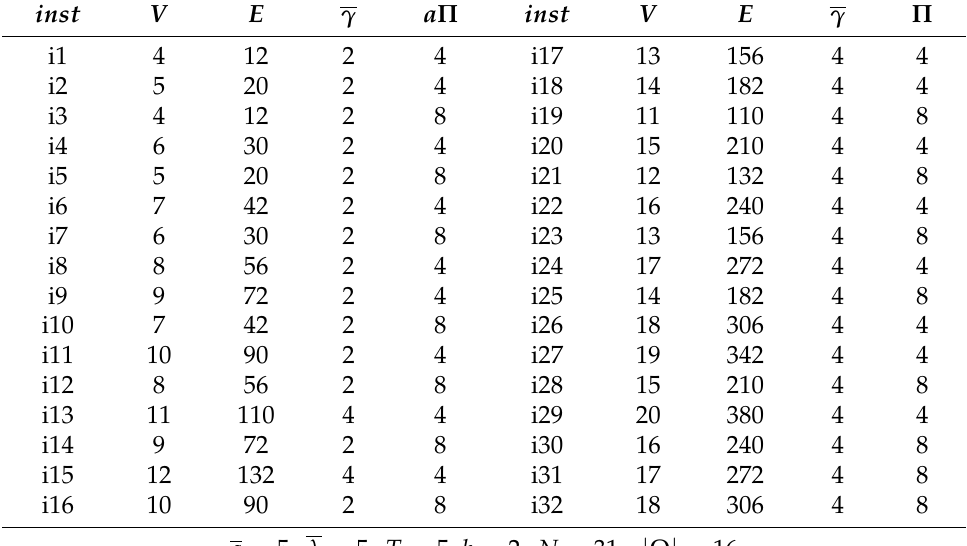
Table 1. S-Hub-NEP problem.